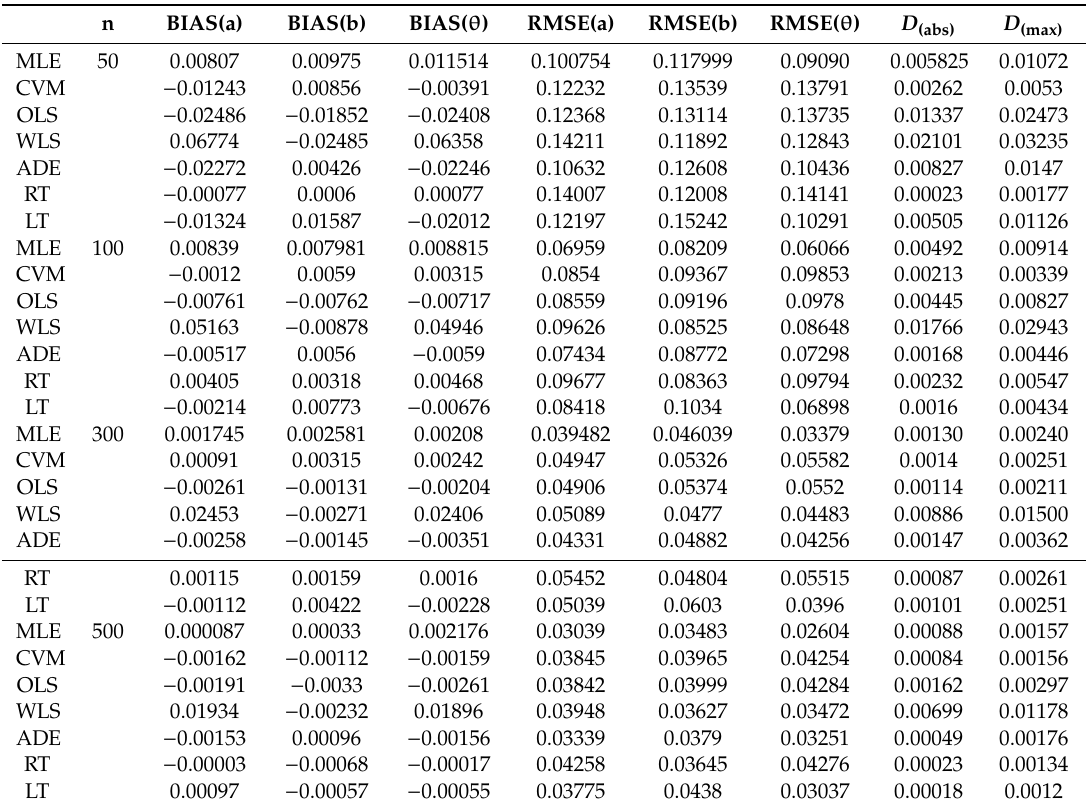
Table 3. Simulation results for parameters a = b = θ = 0.8.